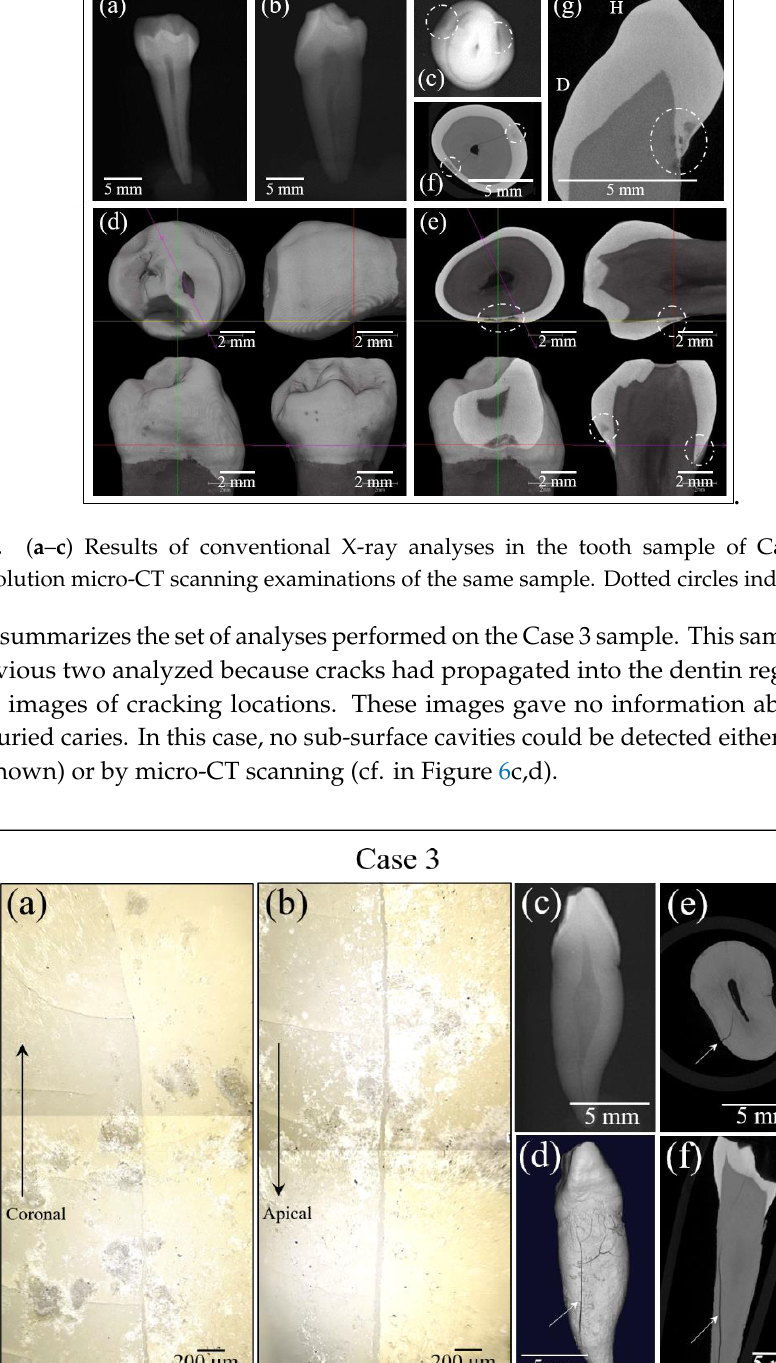
Figure 6. Digital microscope images of cracking locations in ( a ) and ( b ), Images are at 100 × magnification. conventional X-ray image in ( c ), and overall micro-CT scan images in ( d – f ) for the tooth sample in Case 3. Arrows indicate fractures.